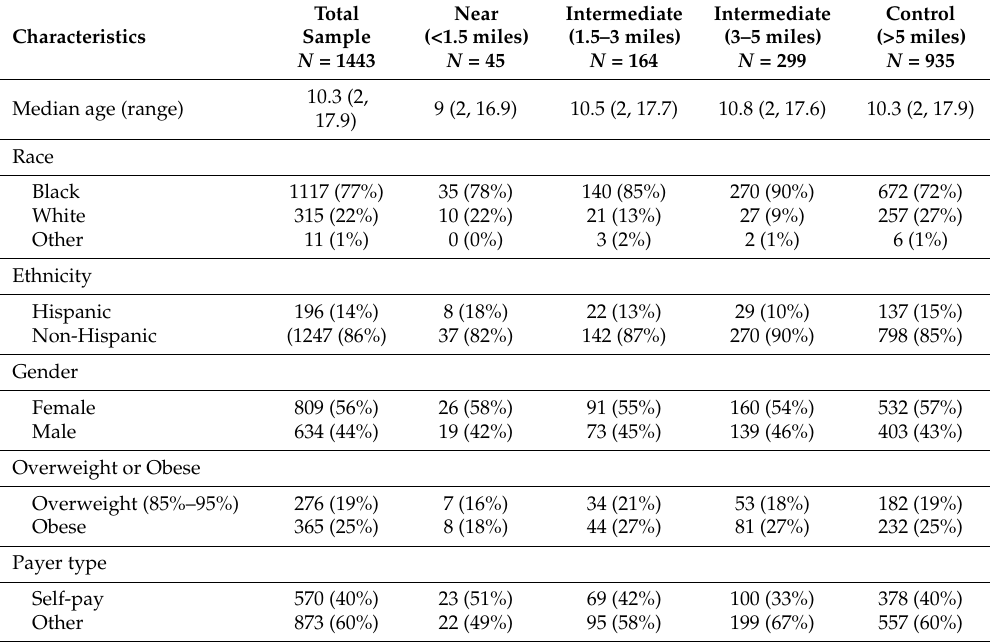
Table 1. Sample descriptive characteristics at baseline.